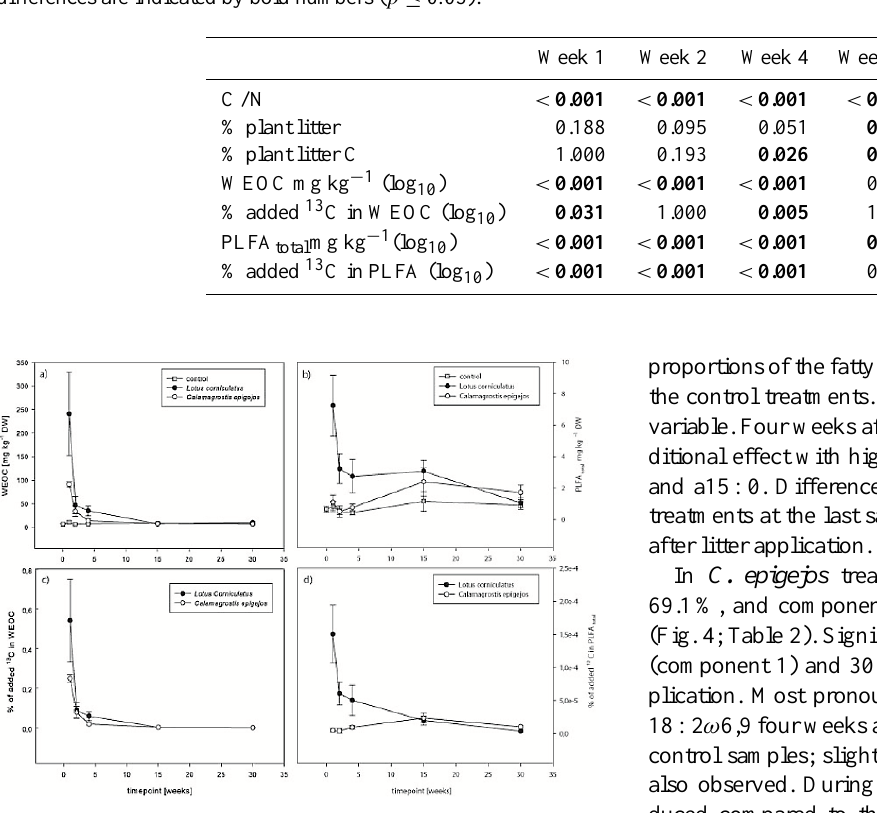
Fig. 2. WEOC (a) and soil microbial biomass (b) based on to- tal PLFA in L. corniculatus and C. epigejos treatments. Rela- tive amount of litter-derived 13 C in WEOC (c) and soil microbial biomass (d) ; values are expressed as a percentage of initially added 13 C, normalised with controls. Results are shown with standard de- viations ( n =